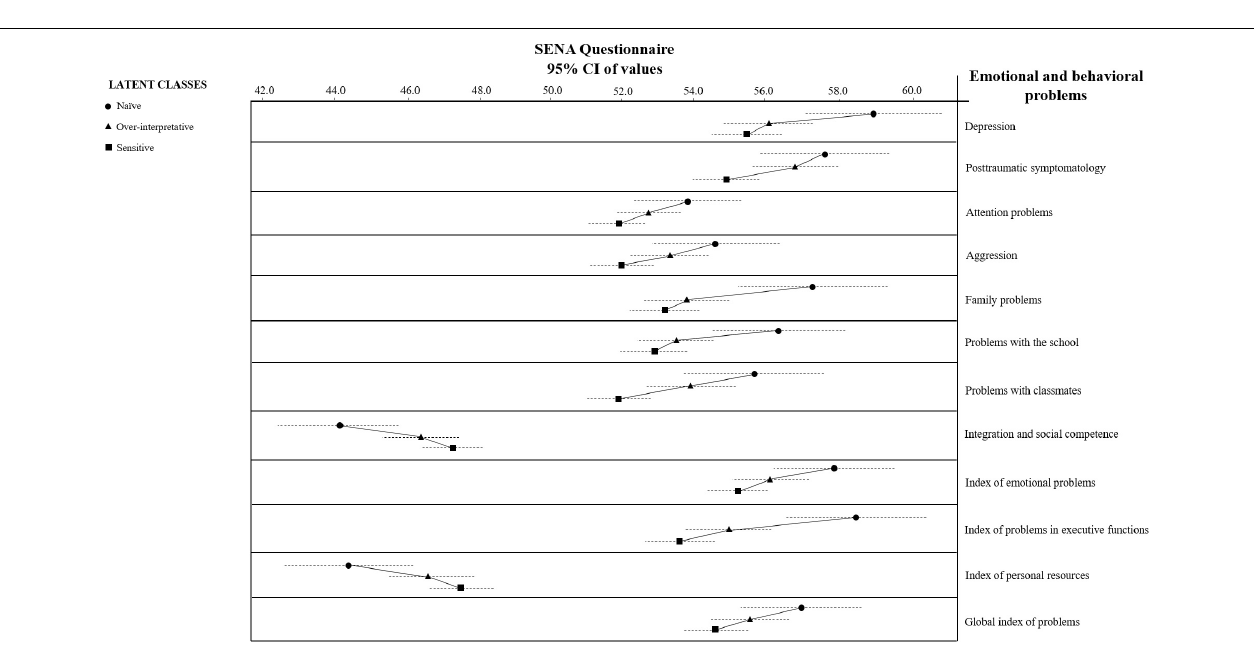
FIGURE 4 | Emotional and behavioral problems from SENA questionnaire showing significant differences regarding latent